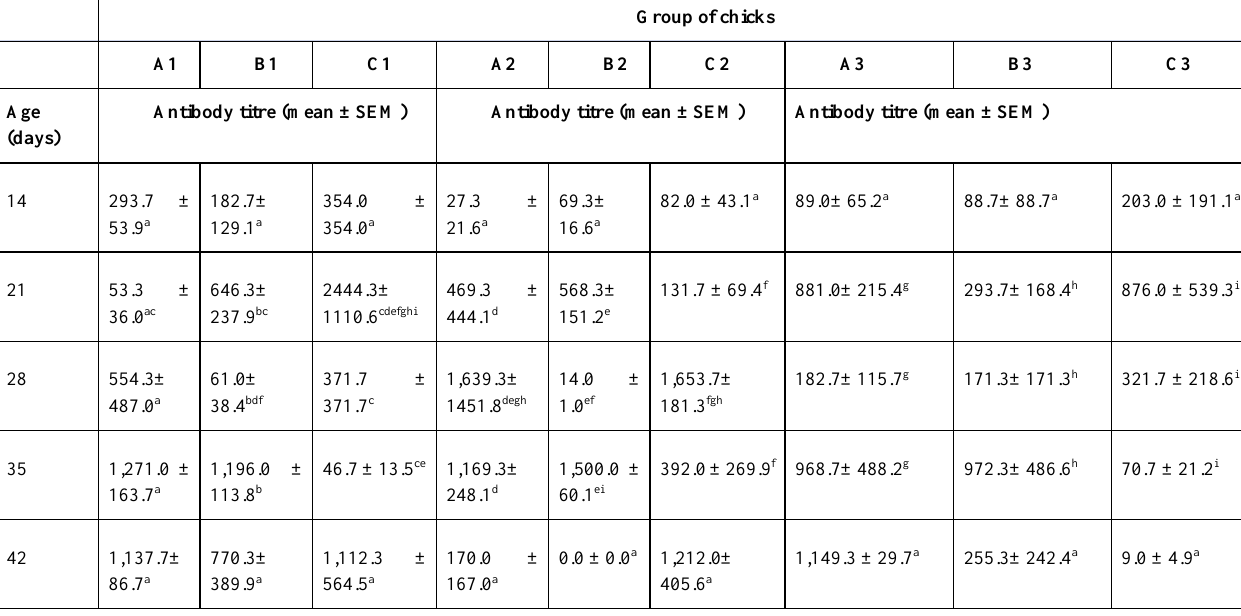
Mean ± SEM values in the same row with multiple superscripts are statistically significantly different at p < 0.05 according to Bonferroni Posthoc test. Mean ± SEM values in the same row with same and or single superscript are NOT statistically significantly different at p > 0.05 according to Bonferroni Posthoc test. Table 2. Antibody responses of ISA brown pullets from three commercial hatcheries to different doses of avian influenza H5 inactivated vaccine administered at 14 and 28 days of age via the subcutaneous route.